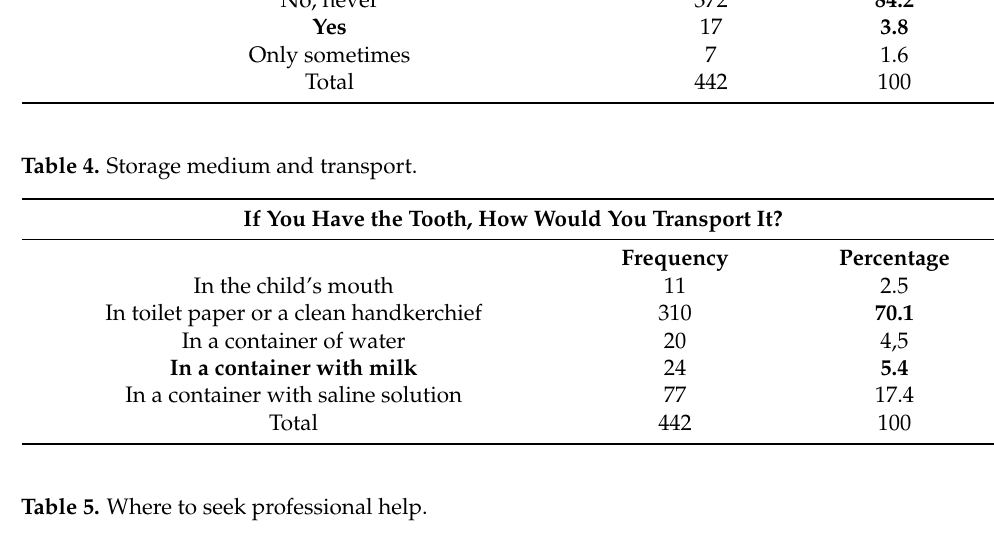
Table 5. Where to seek professional